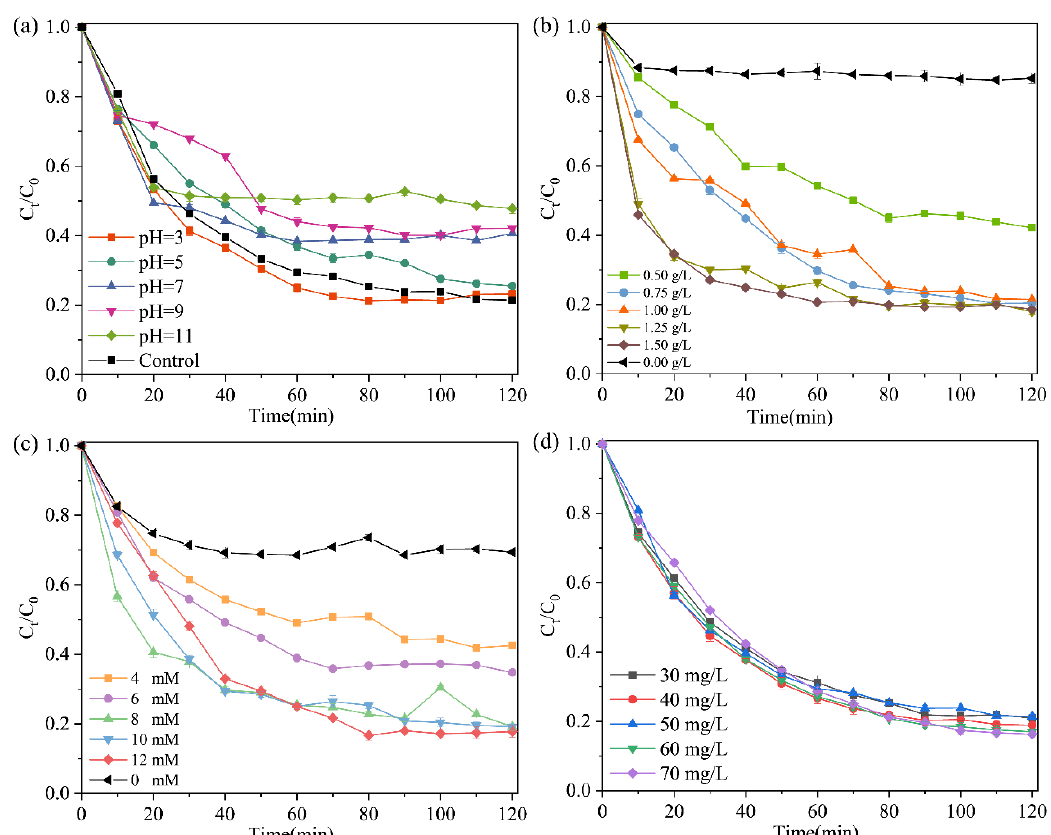
Figure 5. ( a ) The influence of pH (ranging from 3 to 11) on TCH removal efficiency; ( b ) Effect of IO@ESBC dosage (ranging from 0.50 g/L to 1.50 g/L) on TCH removal efficiency; ( c ) Effect of PS dosage (ranging from 4 mM to 12 mM) on TCH removal efficiency; ( d ) Effect of the original TCH concentration (ranging from 30 mg/L to 70 mg/L) on TCH removal efficiency.